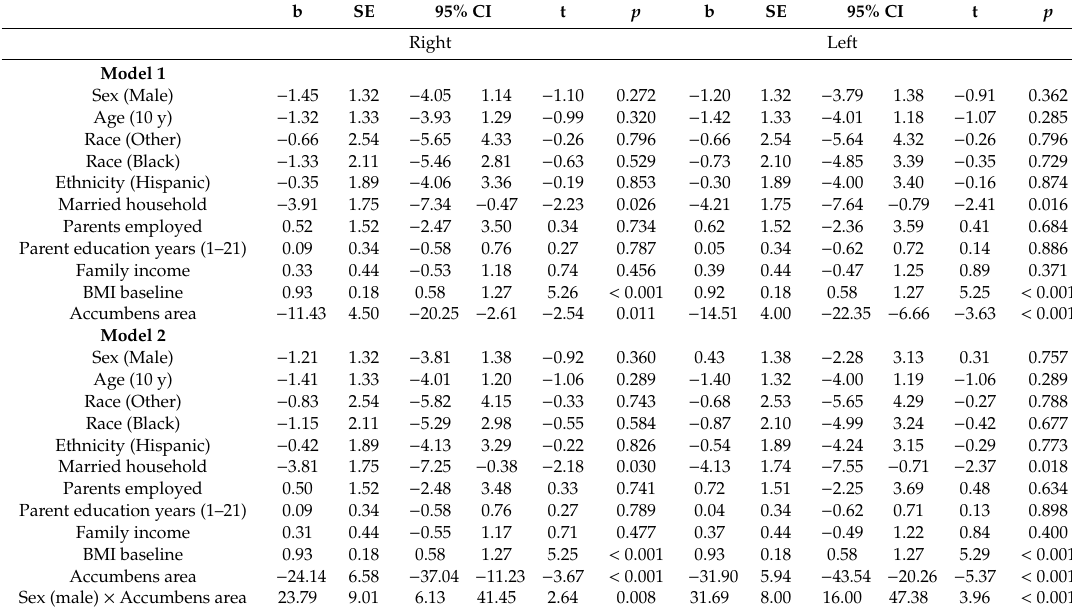
Table 3. Overall regression